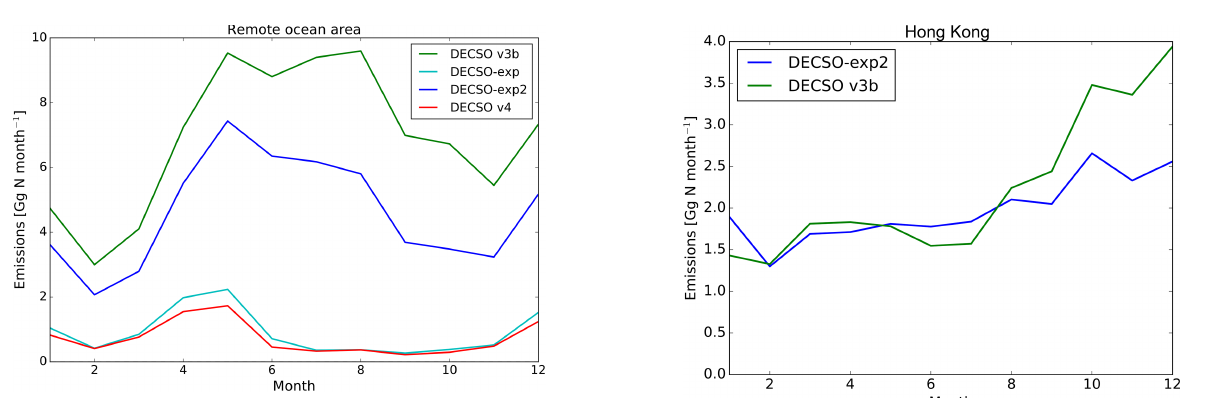
Figure 4. The monthly emissions in Hong Kong in 2013. DECSO- exp2 indicates the emissions derived using DECSO with the 3 σ constraint. DECSO v3b indicates the emissions derived with the OmF